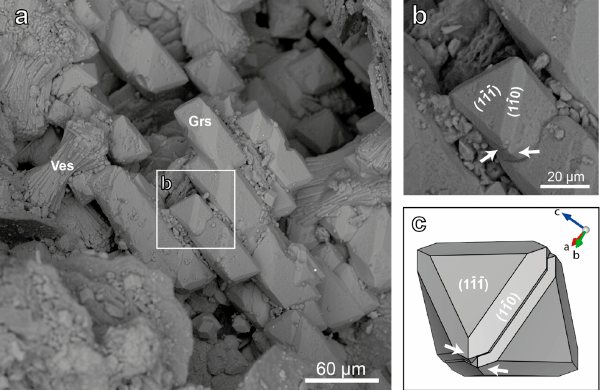
Figure 7. BSE image of twinned (H 4 O 4 ) 4 − -substituted grossular crystals and split vesuvianite aggre- gates ( a ), growth twin of two octahedrally shaped grossular crystals ( b ); model of the merohedral twin by twofold axis along [110] with a 0.05 shift along the c axis ( c ). White arrows indicate border of two twin components.